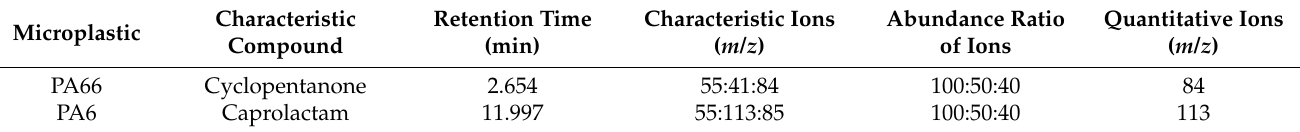
Table 1. Microplastic ion